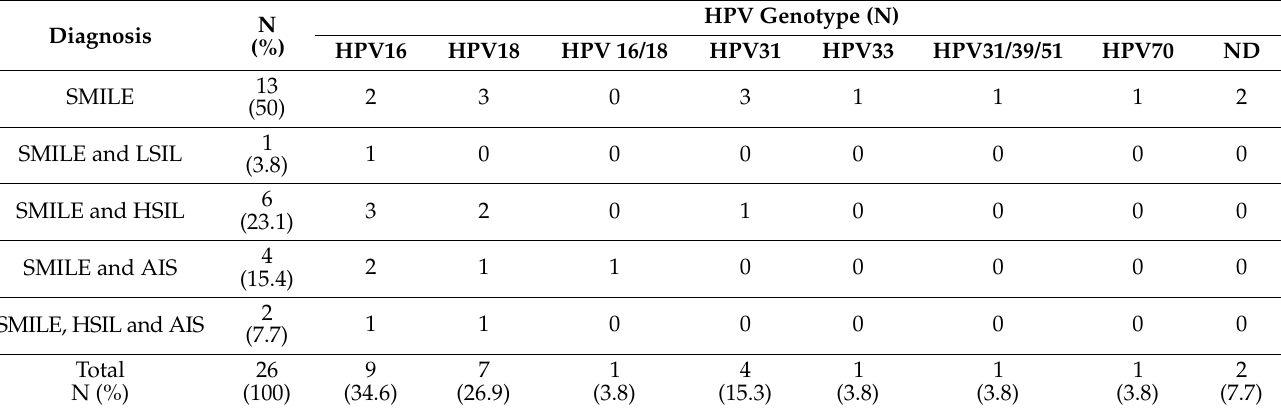
Table 2. Combination of SMILE with other cervical precancerous lesions and results of HPV genotyping.